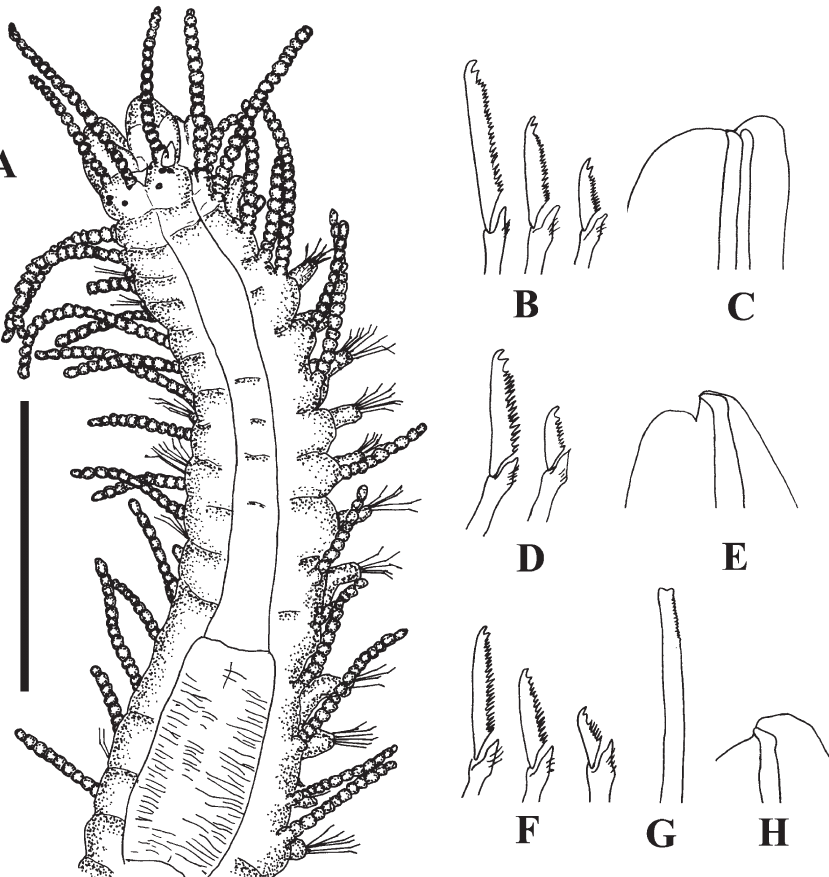
Fig . 9. – Syllis gerlachi . (A) Anterior end, dorsal view; (B) Anterior falciger chaetae; (C) Anterior aciculae; (D) Mid-body falciger chaetae; (E) Mid-body aciculae; (F) Posterior falciger chaetae; (G) Simple dorsal chaetae; (H) Posterior aciculae. Scale bars: A, 500 µm; B-H, 50